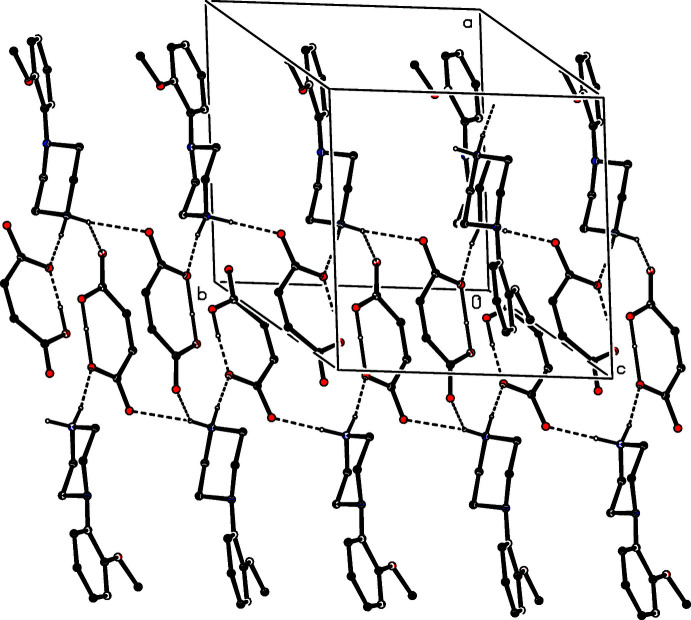
Part of the crystal structure of compound (XIII) showing the formation of a hydrogen-bonded ribbon of (14) and (30) rings running parallel to [010]. Hydrogen bonds are drawn as dashed lines and, for the sake of clarity, the H atoms bonded to C atoms have been omitted.